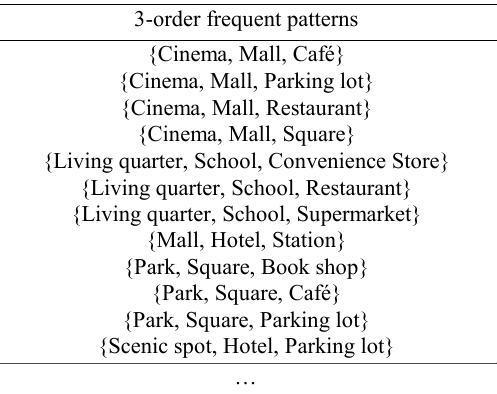
Table 3. 3-order frequent patterns